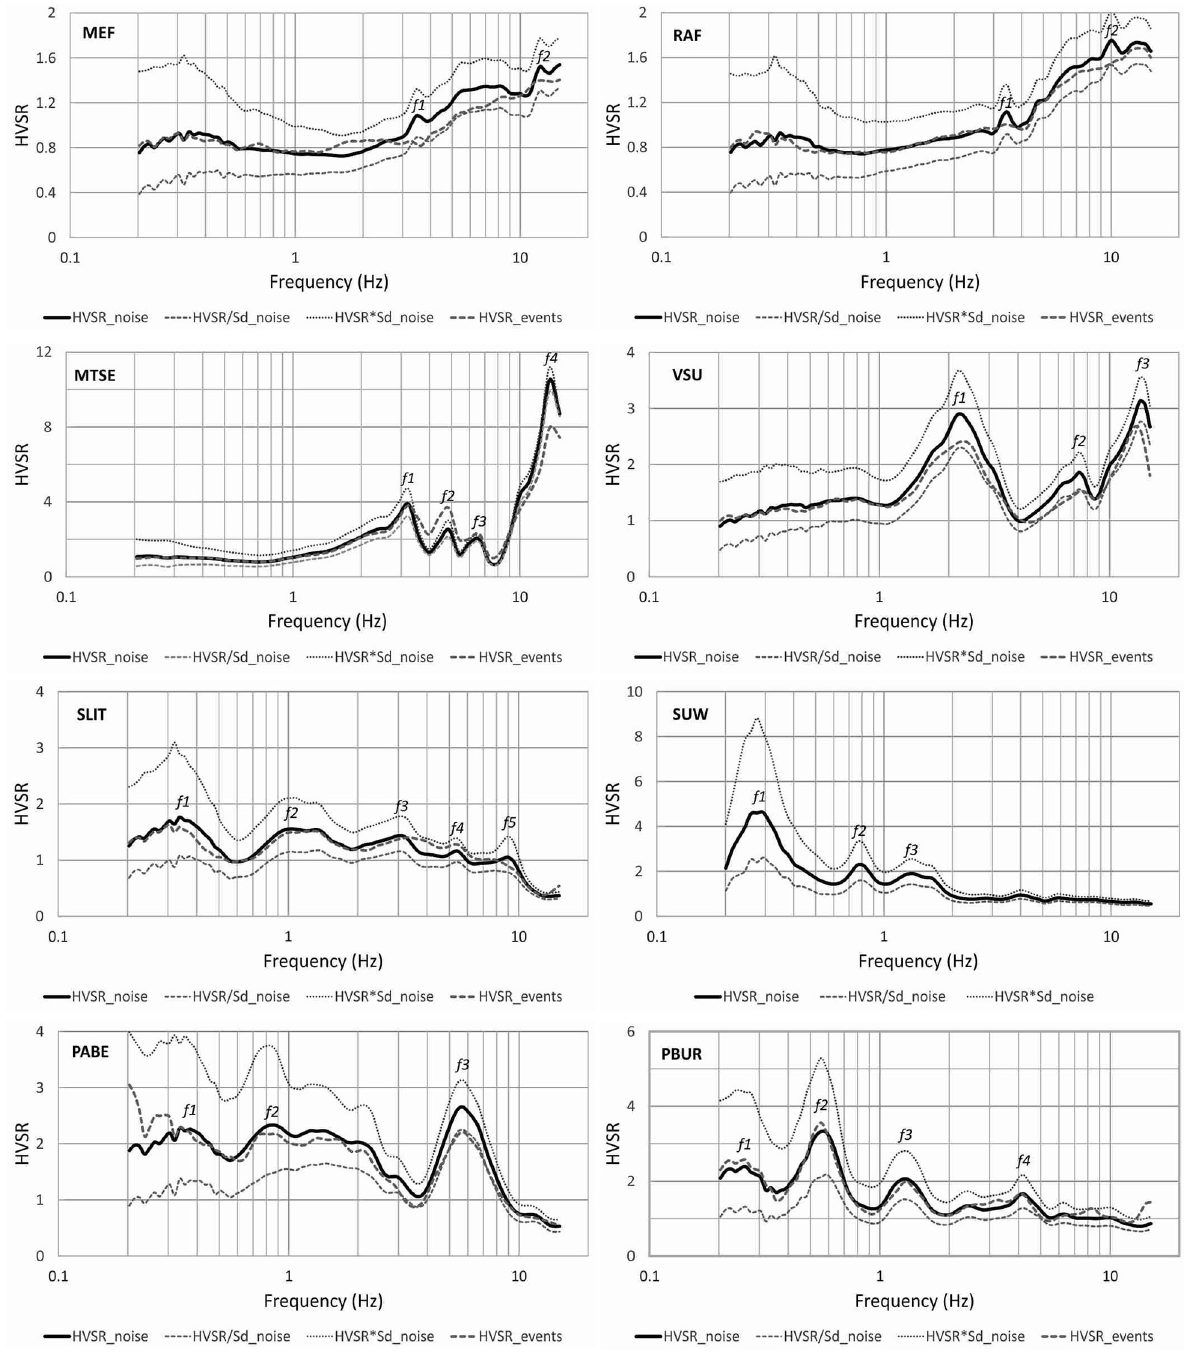
Fig. 2. Horizontal to vertical spectral ratios (HVSRs) for stations of the BAVSEN network. HVSR_noise – the generalized curve of the HVSR for ambient seismic noise; HVSR/Sd_noise and HVSR*Sd noise – the HVSR curve divided and multiplied by the standard deviation Sd; HVSR_events – the generalized curve of the HVSR for seismic events (earthquakes, explosions and other man-made events); f 1 ... f 5 – frequencies of HVSR peaks pointed in Table 1 for relevant seismic